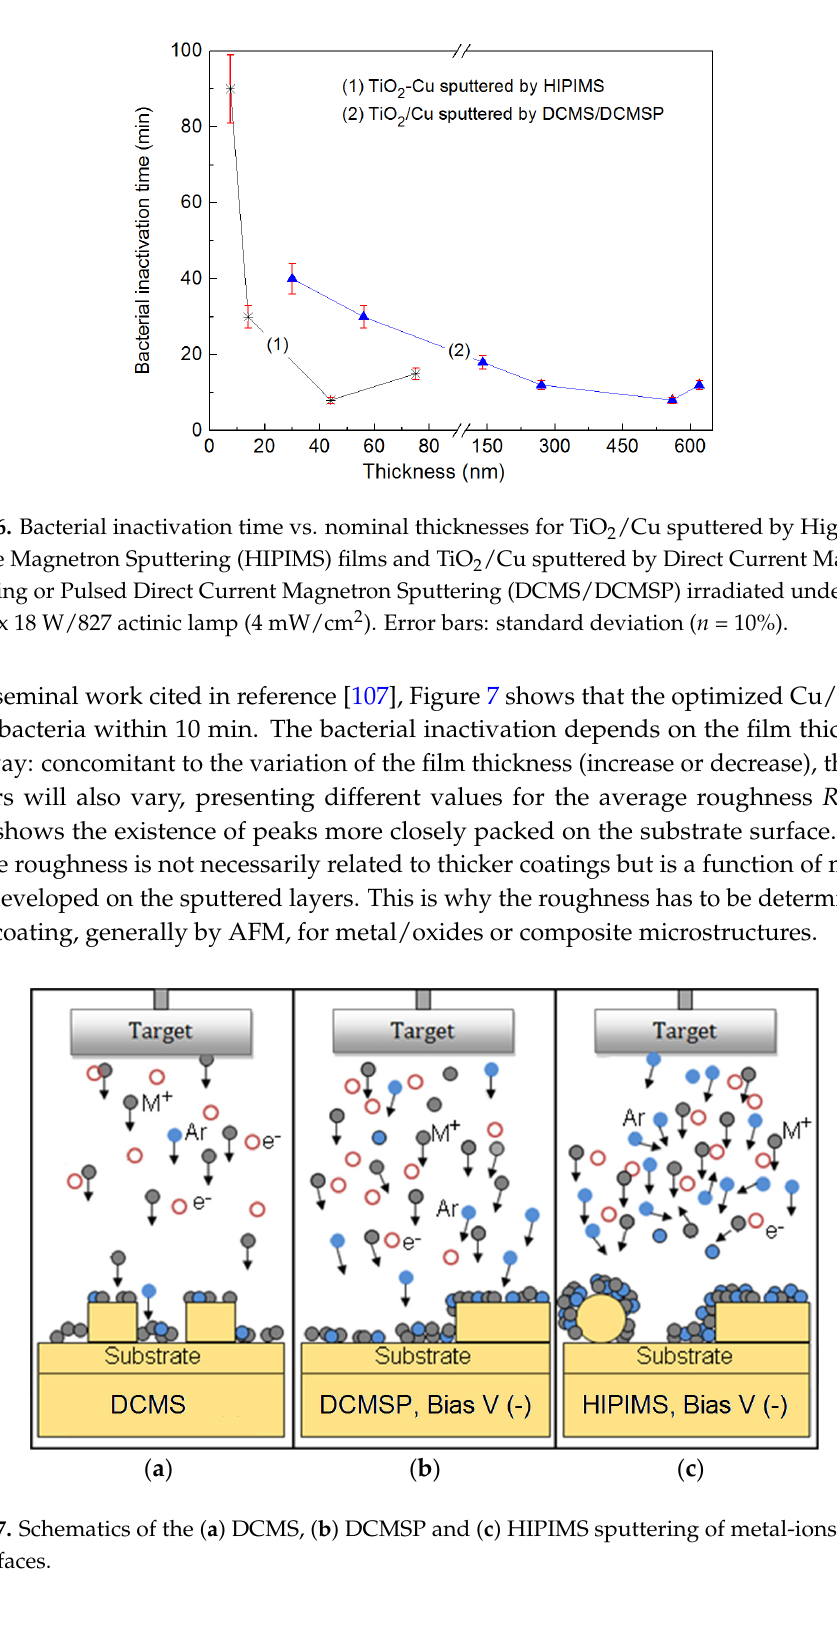
Coatings 2017 , 7 , 20 14 of 28 Figure 5. Ti ‐ ions release from a diverse TiO 2 /Cu (10 min/40 s) cotton sputtered sample as a function of catalyst cycling up to the eighth cycle. 2.7. TiO 2 ‐ Cu Films by HIPIMS: Comparison of the Bacterial Inactivation Performance with DCMS/DCMSP ‐ Films In a recent study, we reported that sputtering by HIPIMS on polyester (PES) showed that thinner TiO 2 ‐ Cu HIPIMS sputtered films (~40 nm) induced bacterial inactivation of E. coli within 9–12 min